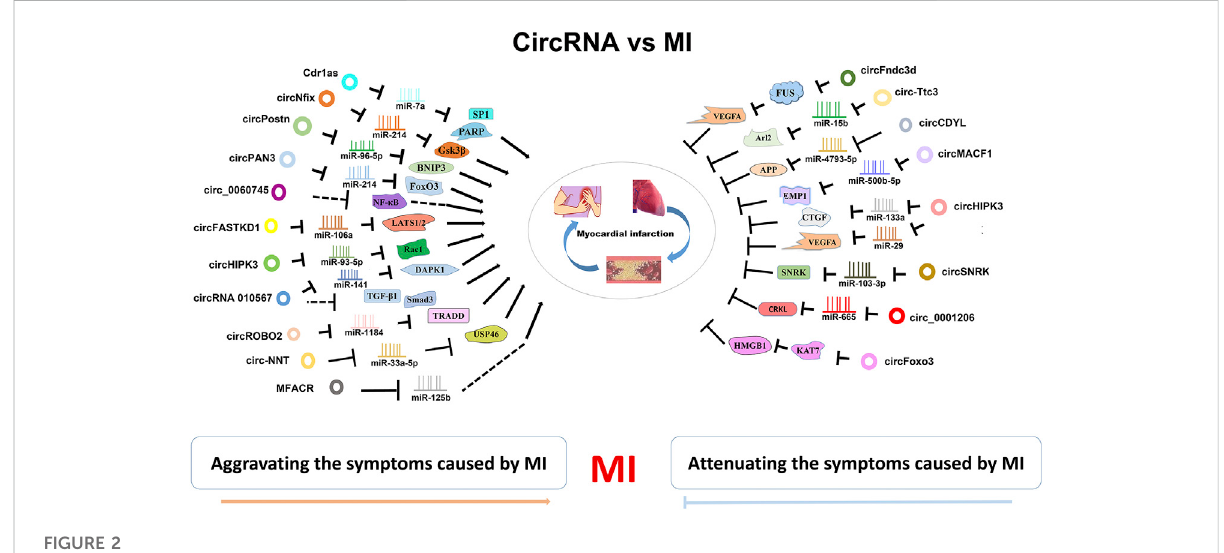
FIGURE 2 CircRNA-miRNA/RBP axies in MI. CircRNAs are widely invovled in MI. They can attenuate or aggravate the MI symptoms by inhibiting various miRNA/RBP